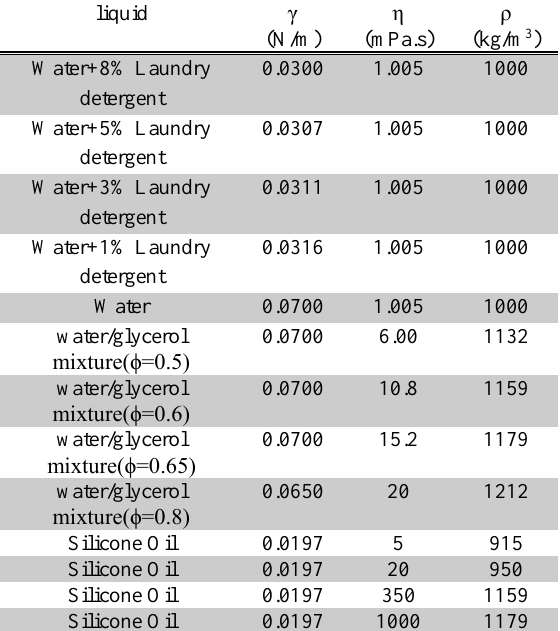
Table 1. Liquids used in the experiments: ϕ is the weight percentage of glycerol to water η is the viscosity; ρ is the density; γ is the surface tension [8,